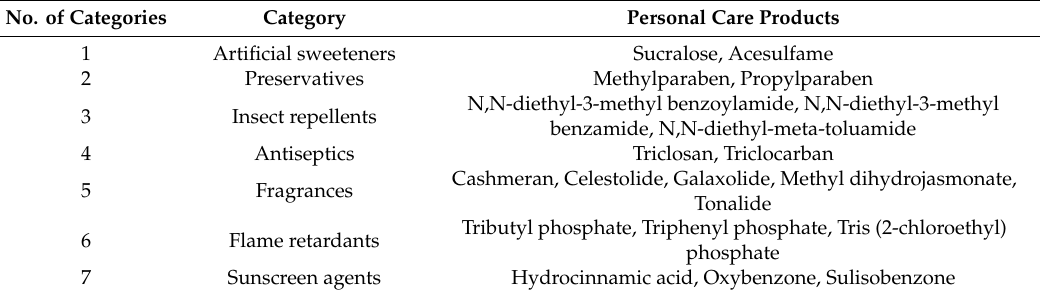
Table 1. Studied personal care products (PCPs) categorized according to their